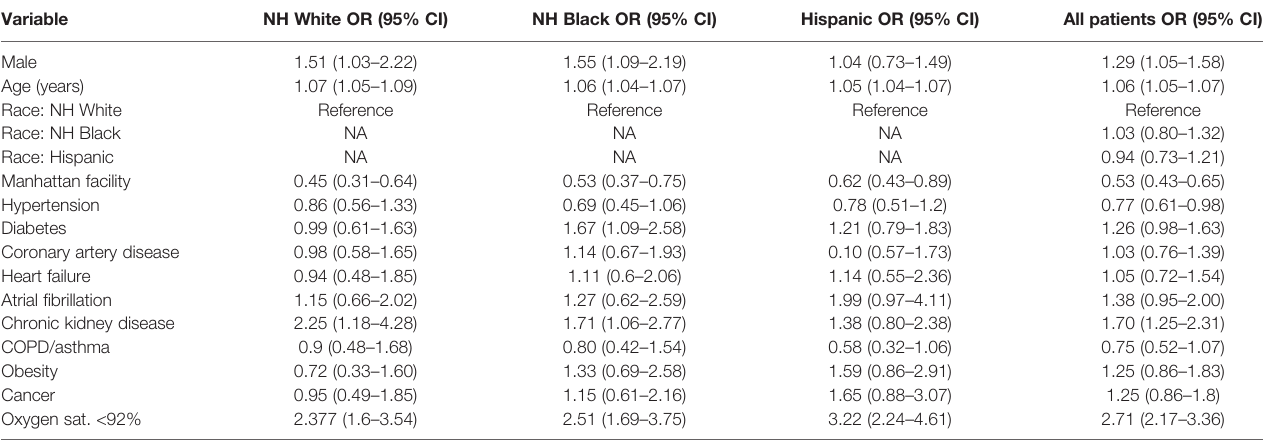
TABLE 2 | Multivariable model predicting in-hospital mortality, strati fi ed by race/ethnicity.